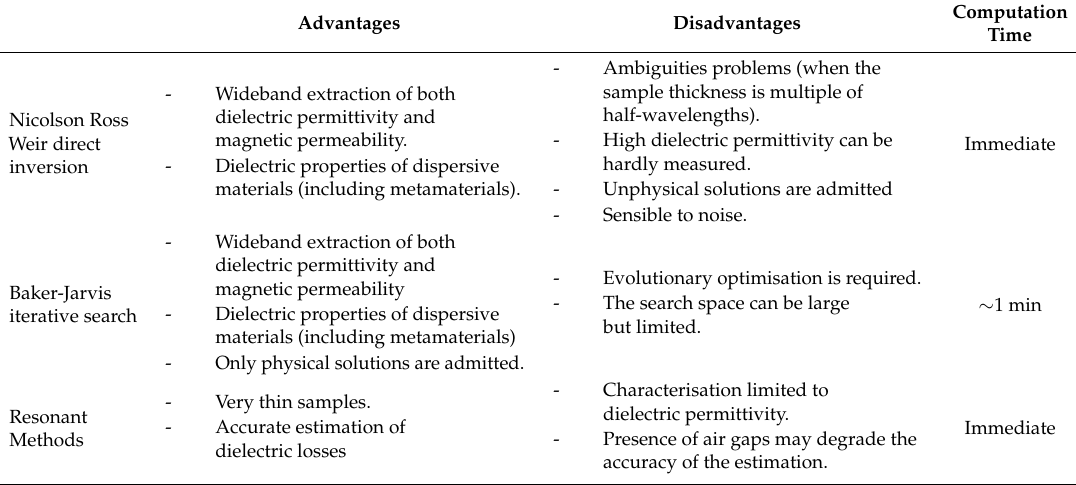
Table 2. Advantages and disadvantages of the direct inversion procedure based on the Nicolson-Ross-Weir algorithm and the Baker–Jarvis iterative search based on the S-parameters cost function.